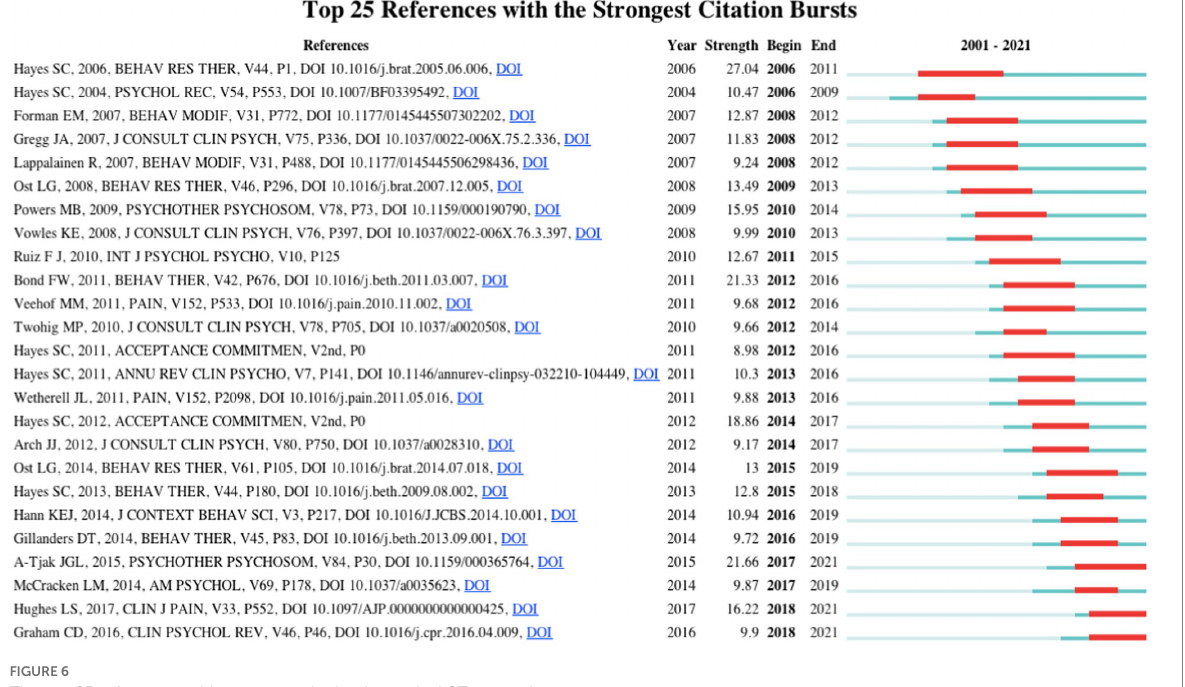
FIGURE 6 The top 25 references with strongest citation bursts in ACT